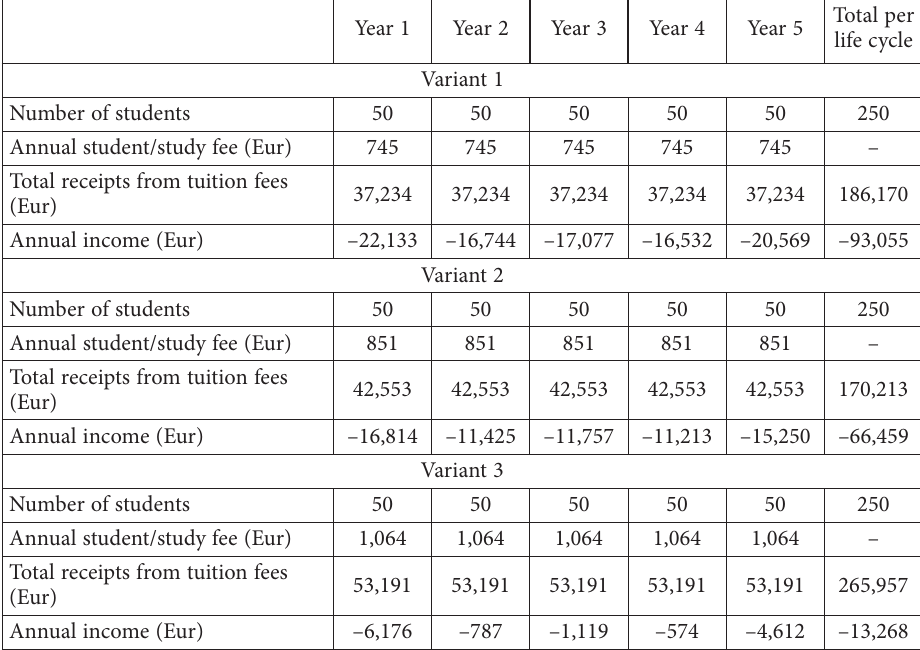
Table 12. Sensitivity analysis according to the value of the annual fee – one-way